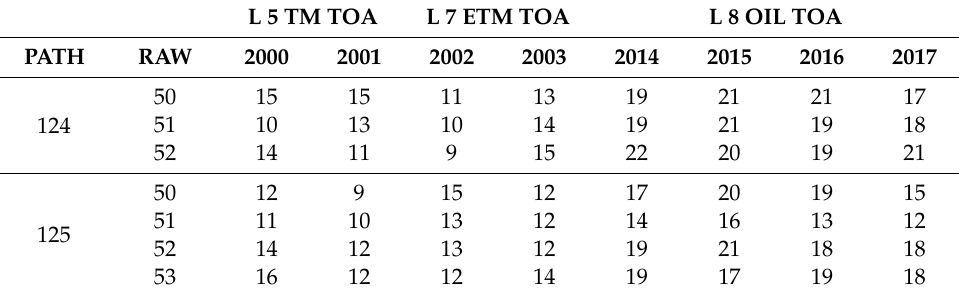
Table A1. Image dates and number of Landsat collections accessed from the GEE for land surface phenology extraction in this